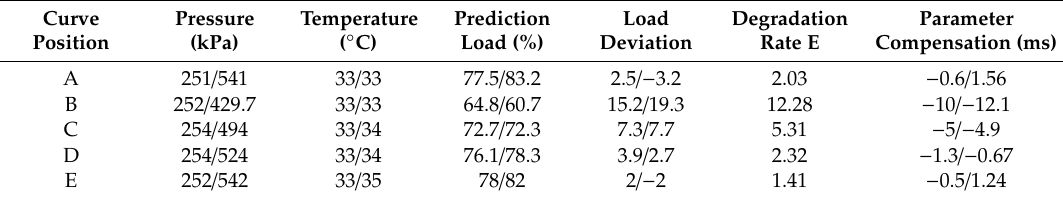
Figure 24. ( a ) First-stage exhaust buffer tank pressure of Experiment 1; ( b ) second-stage exhaust buffer tank pressure of Experiment 1.